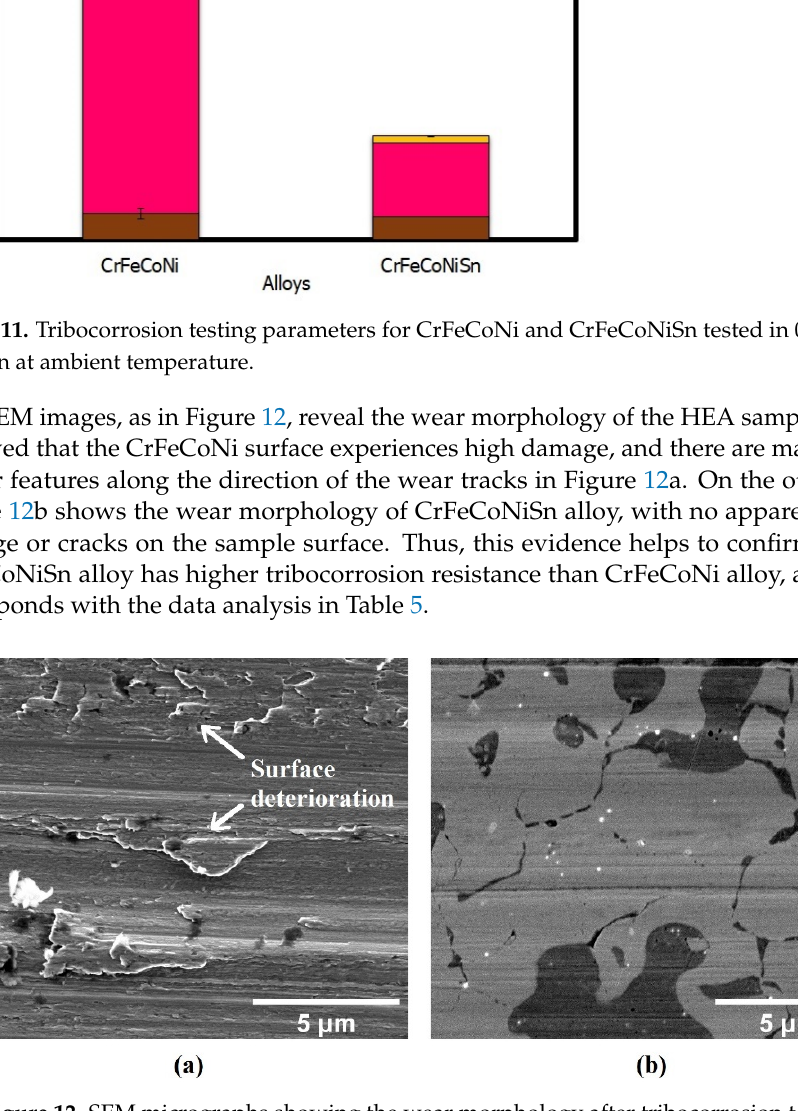
Figure 12. SEM micrographs showing the wear morphology after tribocorrosion testing of ( a ) CrFeCoNi and ( b ) CrFeCoNiSn.